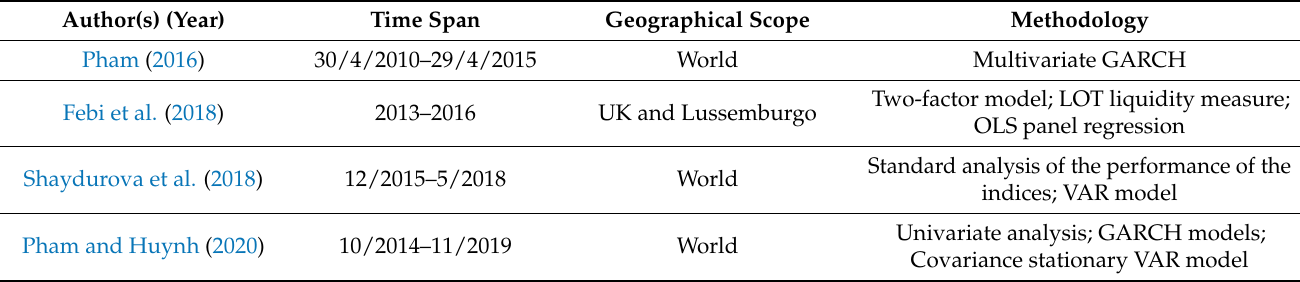
Table 9. “Green bond market performance analysis” empirical literature by the type of sample and methodology. Author(s) (Year) Time Span Geographical Scope Methodology Pham (2016) 30/4/2010–29/4/2015 World Multivariate GARCH Two-factor model; LOT liquidity measure; 2013–2016 UK and Lussemburgo OLS panel regression Standard analysis of the performance of the Shaydurova et al. (2018) 12/2015–5/2018 World indices; VAR model Univariate analysis; GARCH models; 10/2014–11/2019 World Covariance stationary VAR